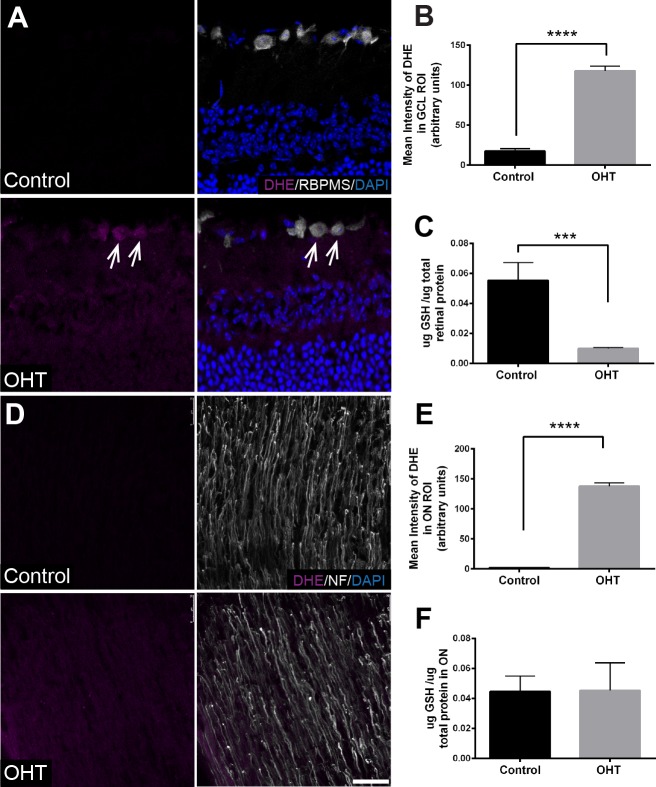
Superoxide accumulation in the retina and ON and decreased GSH in the retina after 4 weeks of OHT. (A) Immunofluorescence of sagittal retinal sections shows dihydroethidium (DHE, magenta), a marker of superoxide production, in OHT retina compared with control. Colocalization of DHE with RBPMS in RGCs of the OHT retina (arrows). RGCs immunolabeled with RBPMS (white), nuclei by DAPI (blue). Retinal layers labeled GCL, INL, and ONL. (B) Significant increase (****P < 0.0001) in the mean intensity of DHE in the GCL (118 ± 6.023, n = 12) of OHT retinas compared with control (17.52 ± 4.865, n = 8). Scale bar: 25 μm. (C) Significant decrease (***P < 0.001) of total GSH level in OHT retinas (0.010 ± 0.001, n = 7) compared with control (0.055 ± 0.012, n = 5). (D) Immunofluorescence of longitudinal ON sections show DHE accumulation as a result of OHT compared with control ONs; neurofilament immunolabel of axons in white. (E) The mean intensity of DHE in ONs was significantly greater (****P < 0.0001) in the OHT ONs (137.7 ± 5.668, n = 12) compared with control (1.79 ± 0.479, n = 8). (F) No significant difference (P > 0.05) in total GSH between control ONs (0.044 ± 0.010, n = 5) and OHT ON (0.045 ± 0.018, n = 8).